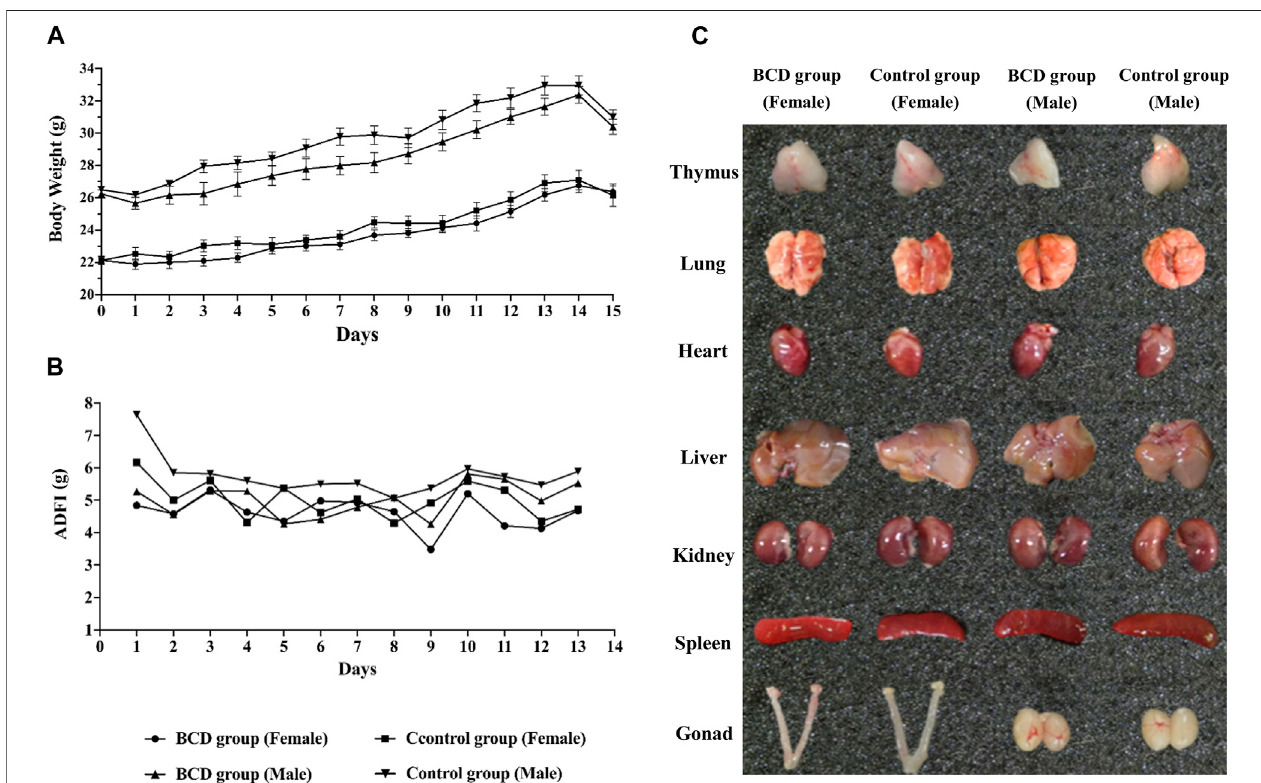
FIGURE 8 | BCD has no acute toxic reaction. Acute toxicity of BCD granules investigated using the urgent toxicity testing method. (A) Body weight trends in BCD and control groups (including female and male mice) during the experiment. (B) ADFI of mice in BCD and control groups. (C) The gross anatomy of thymus, lung, heart, liver, kidney, spleen and gonad (female: including uterus and ovary, male: